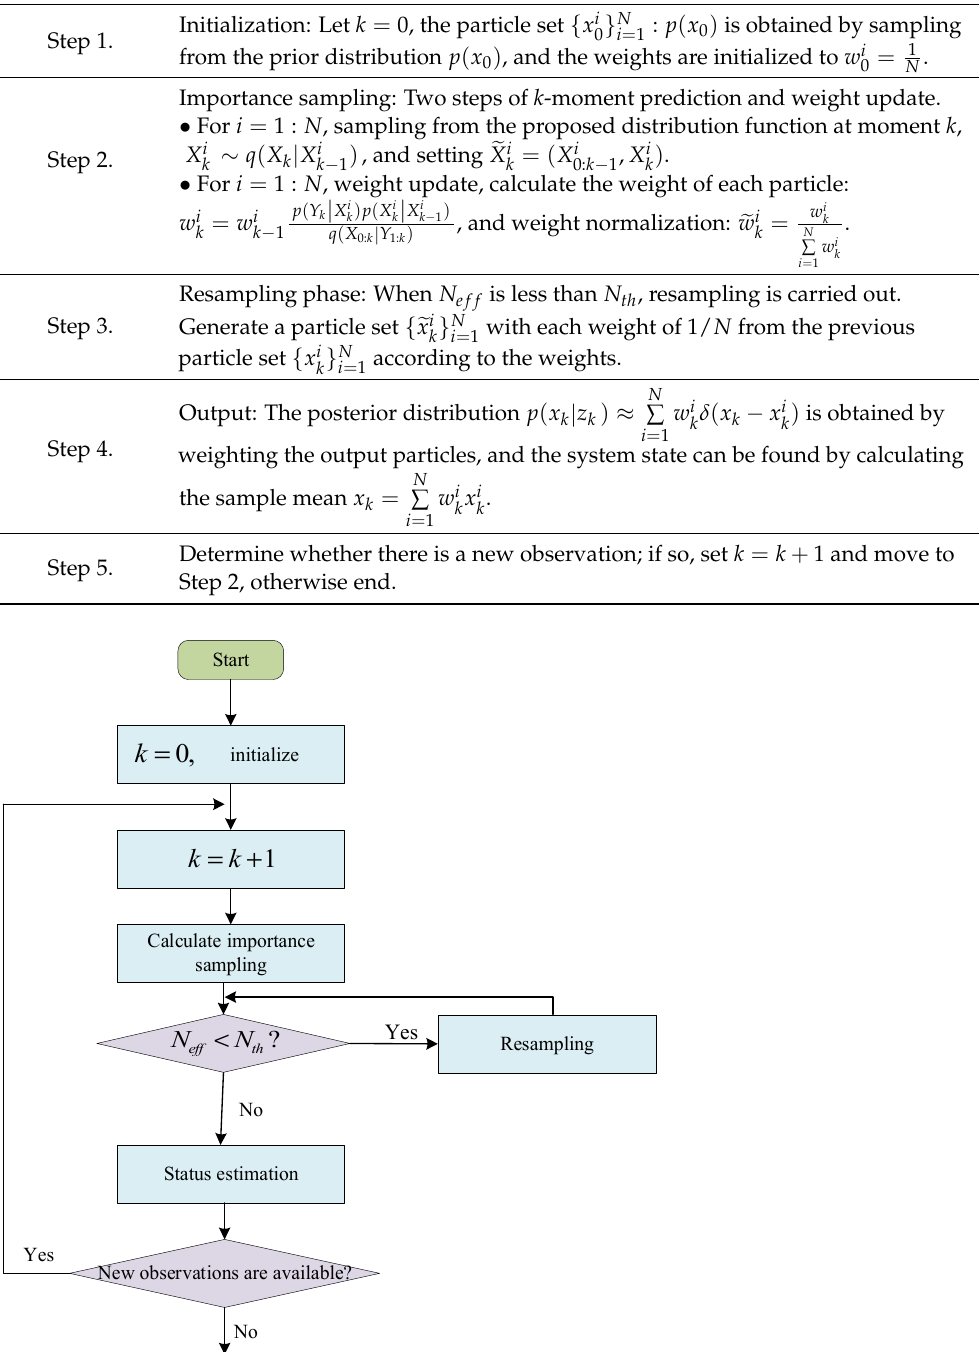
Algorithm 1 : Principle of PF Algorithm